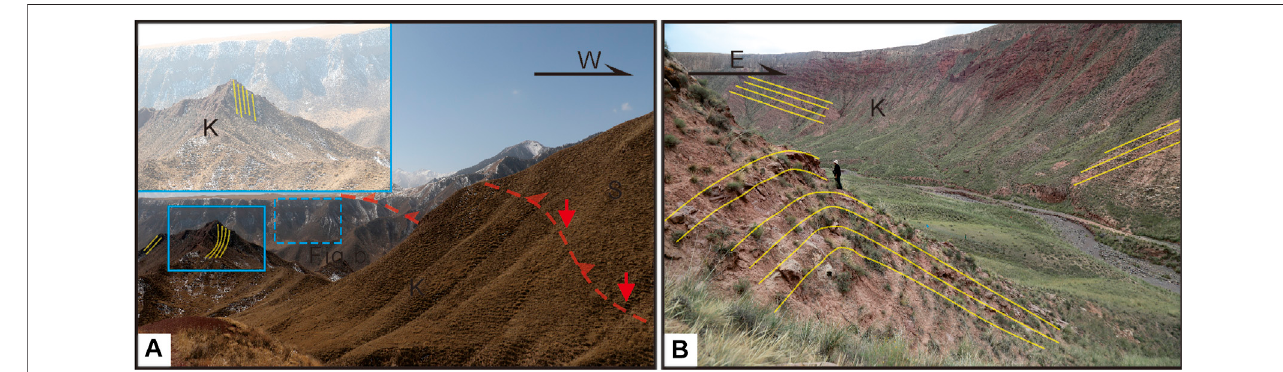
FIGURE9| FieldphotosoftheNQTanditsfoldsinthefootwallstrata.Yellowlinesmeanbedding.( Figure4 forregionallocationofthismap). (A) Fieldphotosofthe NQT and Cretaceous strata in the footwall of the fault. The upper section ’ s Cretaceous strata deformed and are steeply dipping. (B) Field photos of Cretaceous strata near the NQT fault plane. K: Cretaceous strata. N: Neogene